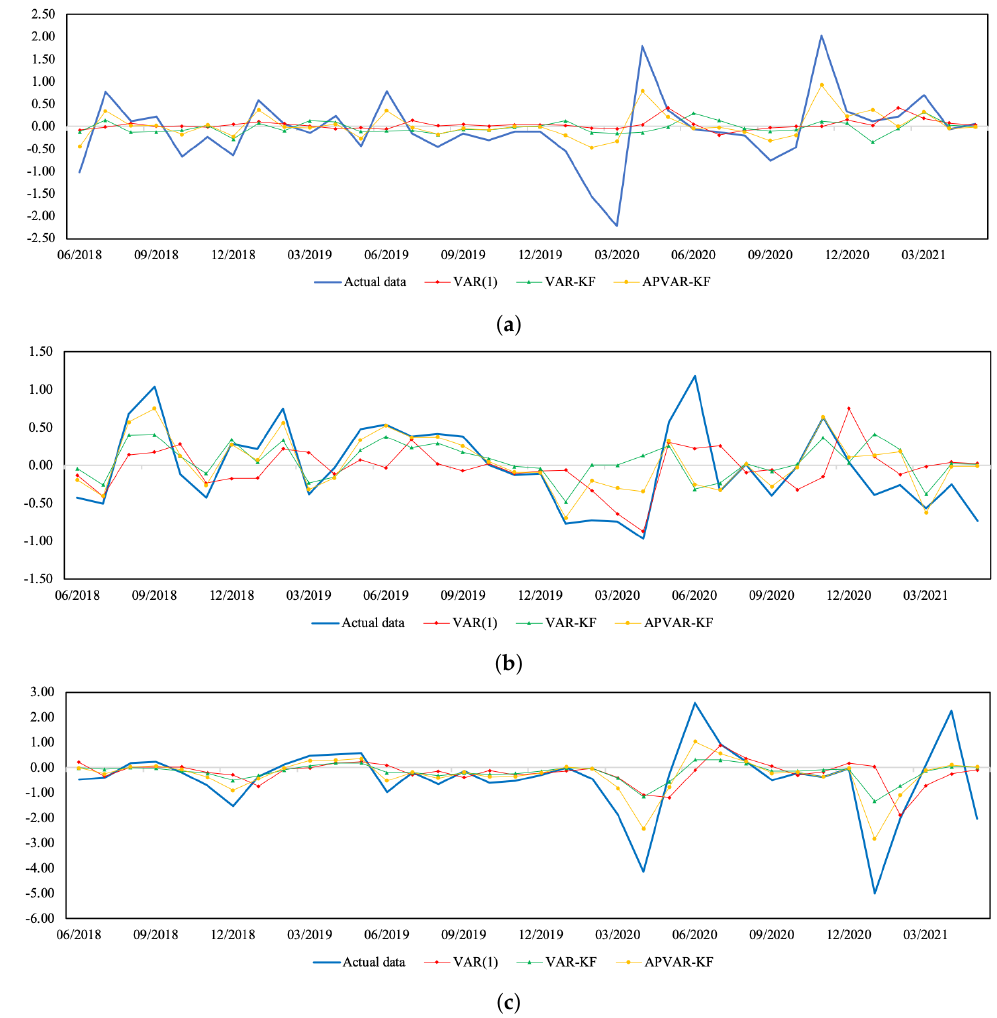
Figure 1. A comparison between the actual data and the estimated values from three methods for Thailand during July 2018–May 2021. ( a ) Normalized SET index return; ( b ) normalized real effective exchange rate return; ( c ) normalized CPI return.